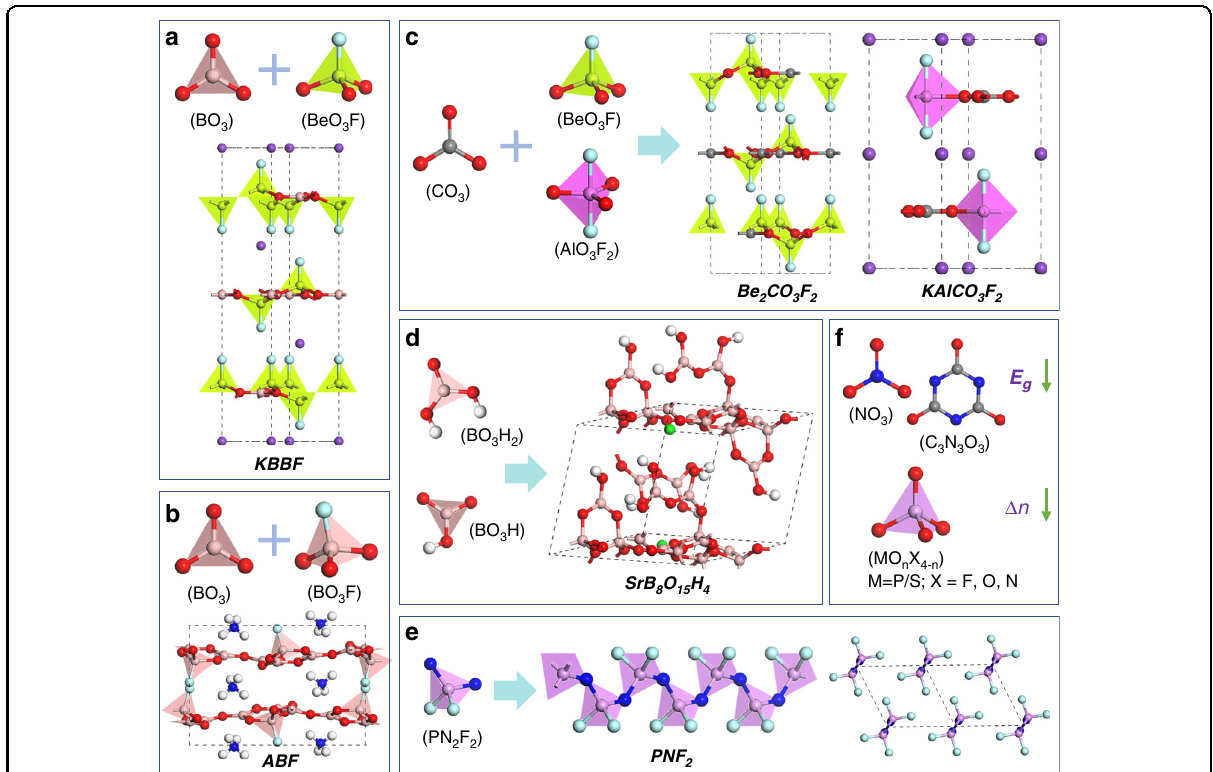
Fig. 3 Anionic group extending strategy and related materials. Basic NLO motifs and structural expansion from KBBF ( a ) and NH 4 B 4 O 6 F (ABF) ( b ) to fl uoride carbonates